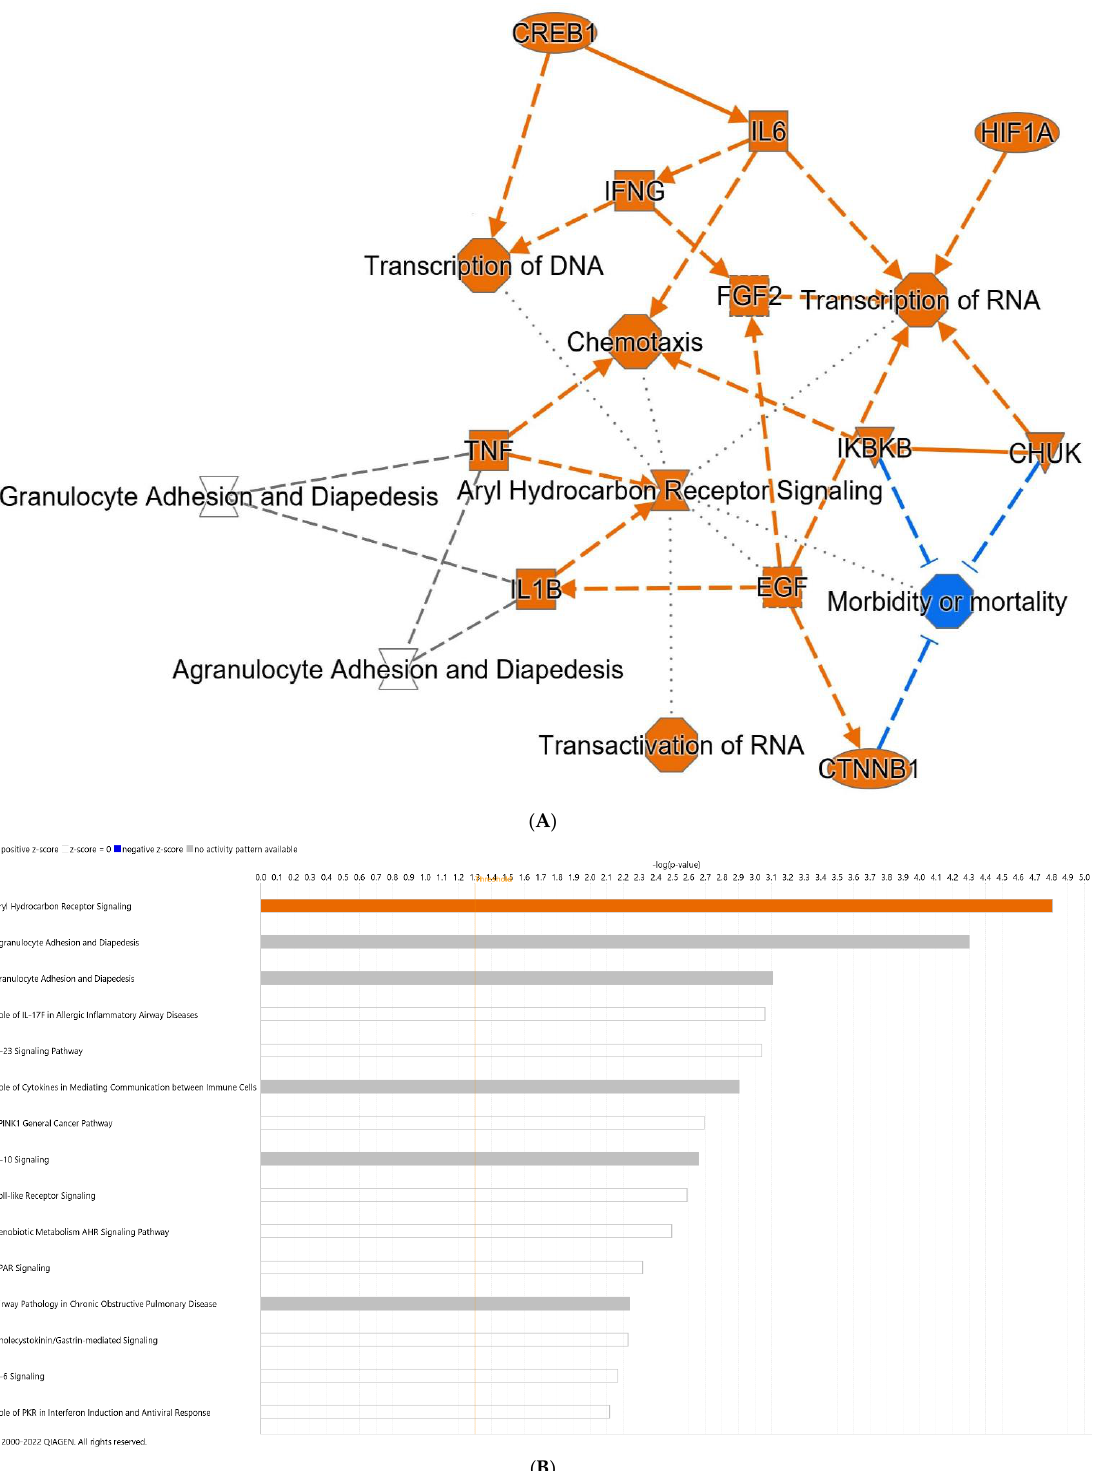
Figure 4. Differential gene expression of terminal ileum of NEC pups compared with pups fed for- mula alone. ( A ) Predicted graphical summary of differentially regulated pathways and genes. ( B ) Top 15 predicted differentially regulated canonical pathways. Blue = Z-score < − 2 (downregulation), orange = Z-score > 2 (upregulation), scaled to activation level (light = low; dark = high). White = Z-score close to 0. Gray = fewer than four molecules in dataset, resulting in no prediction. NEC: necrotizing